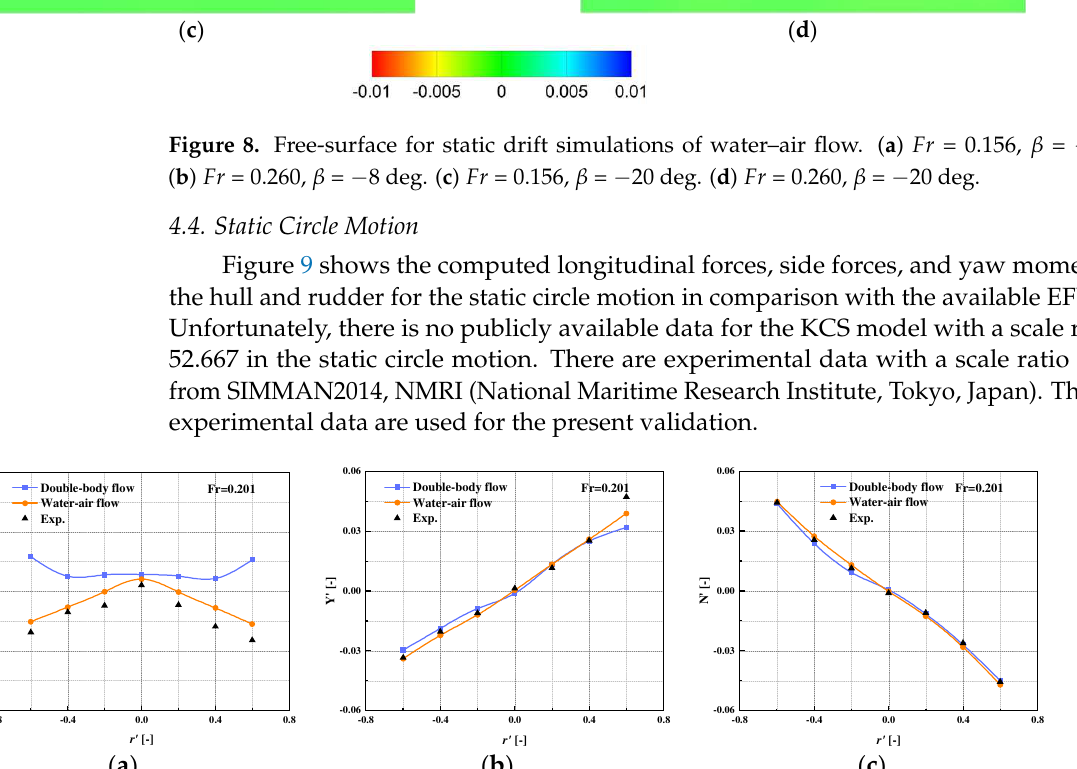
Figure 9. Static turning results of CFD and EFD. ( a ): '